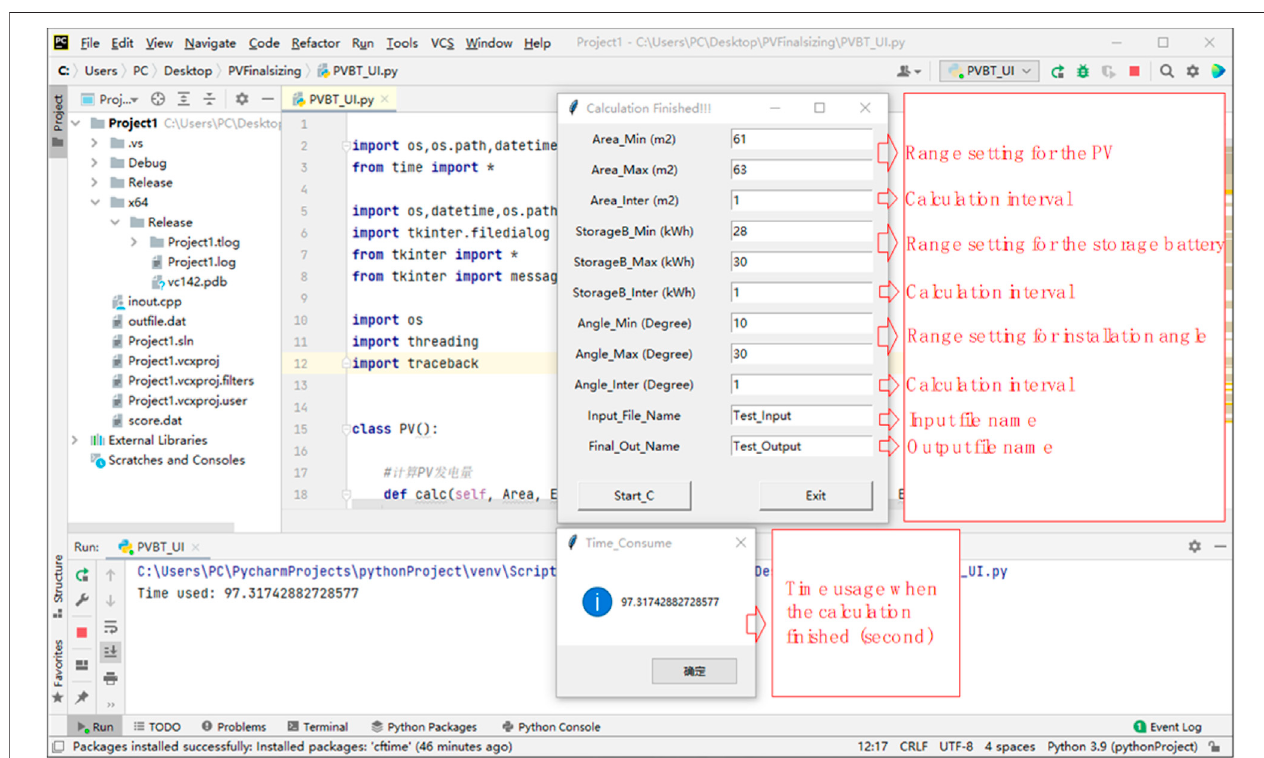
FIGURE 2 | User interface of the program and the complier.